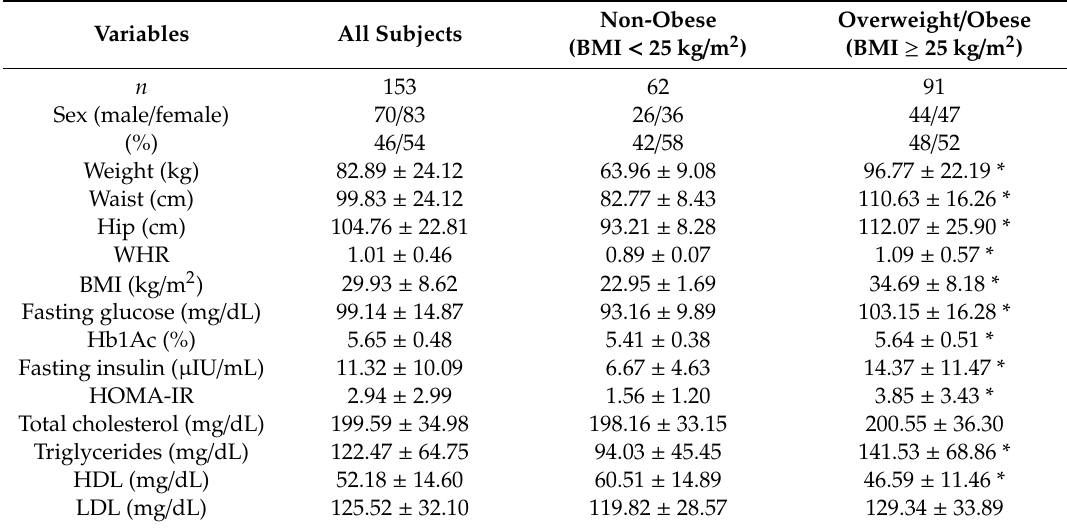
Table 1. General data and characteristics of all subjects.